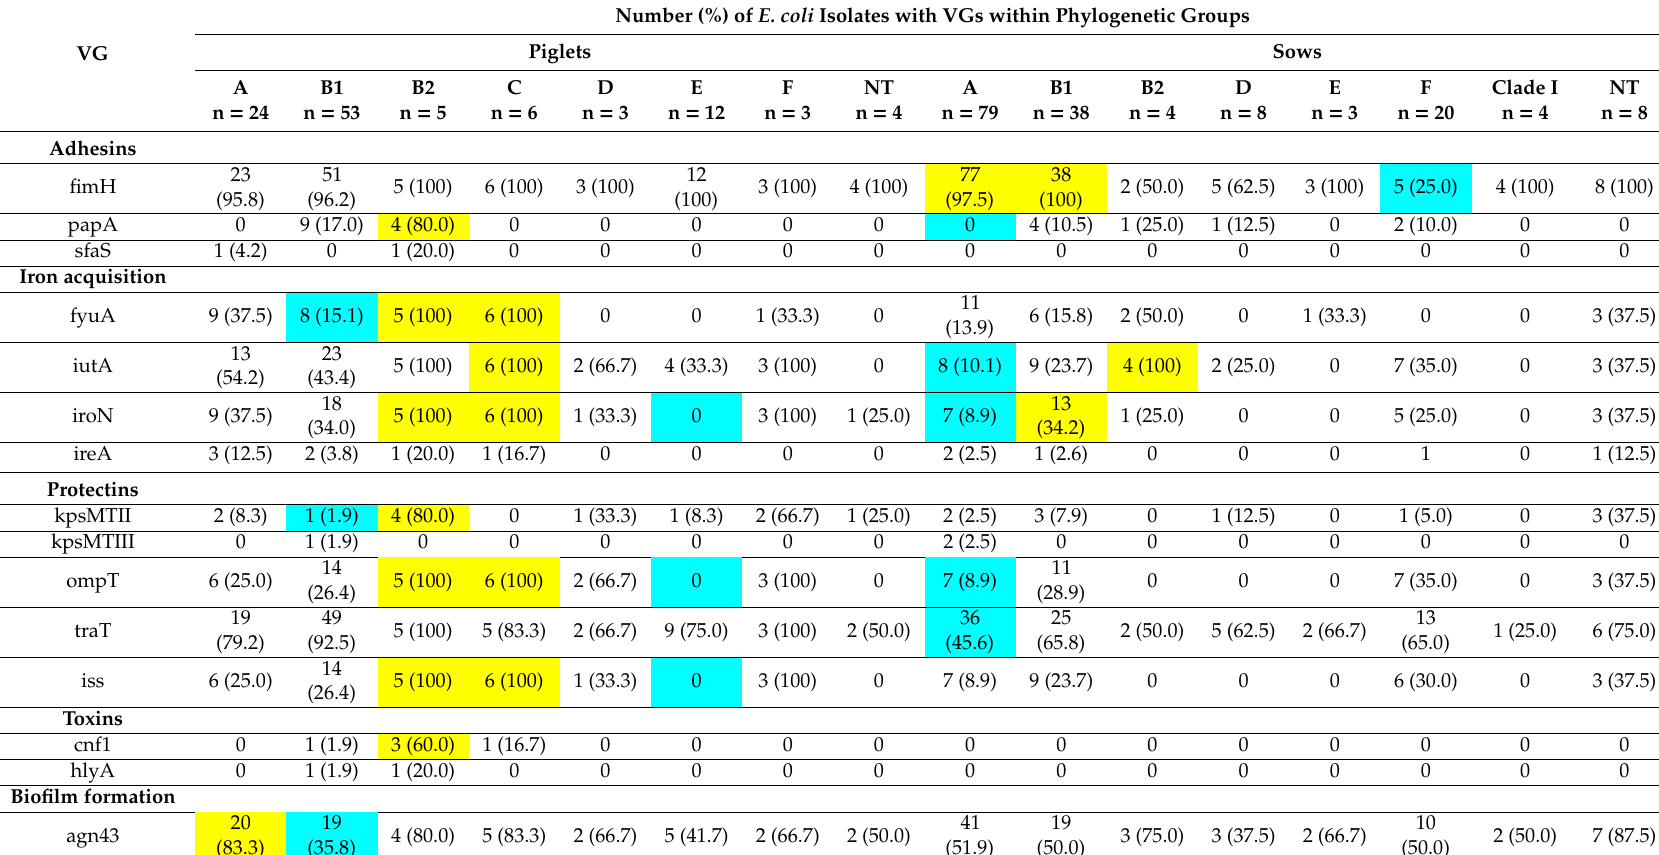
Table 2. Distribution of VGs in extended phylogenetic structure. The frequency of virulence genes among a particular E. coli phylogroup was compared to its prevalence in a group consisting of the isolates of all the other phylogenetic groups using the appropriate test for proportions. Number (%) of E. coli Isolates with VGs within Phylogenetic VG